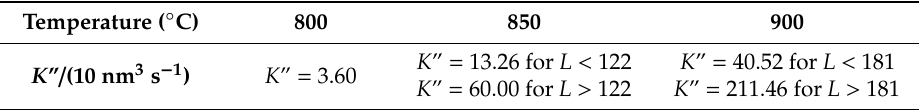
Figure 8. Evolution of the diameter of γ ” precipitates as a function of aging time t . Table 2. The determined K ” values in Equation